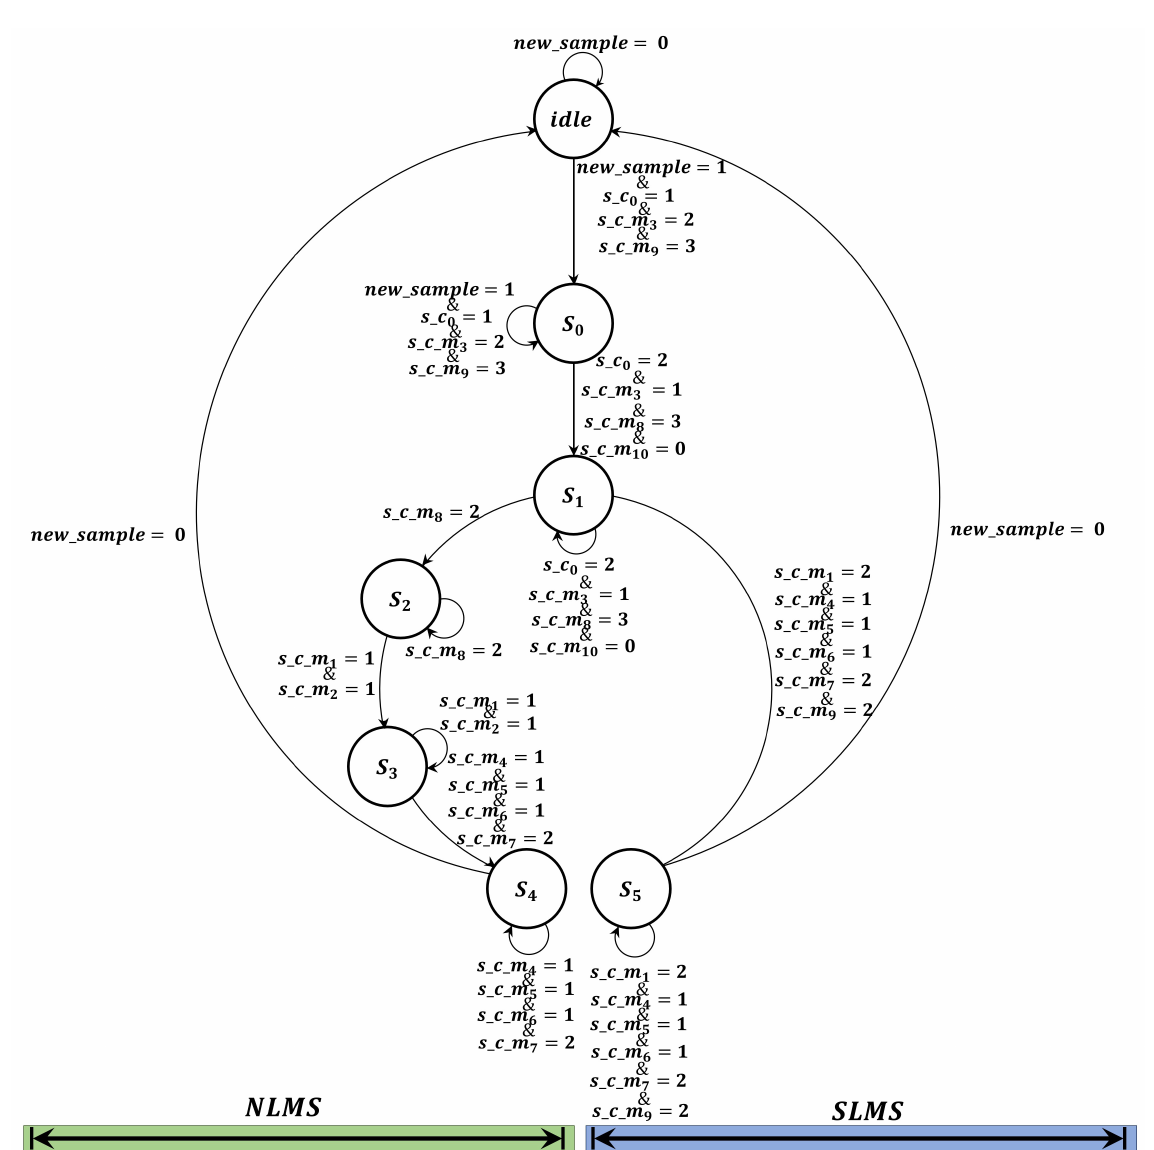
Figure 6. State flow diagram of the control unit to perform either the FxNLMS or FxSLMS